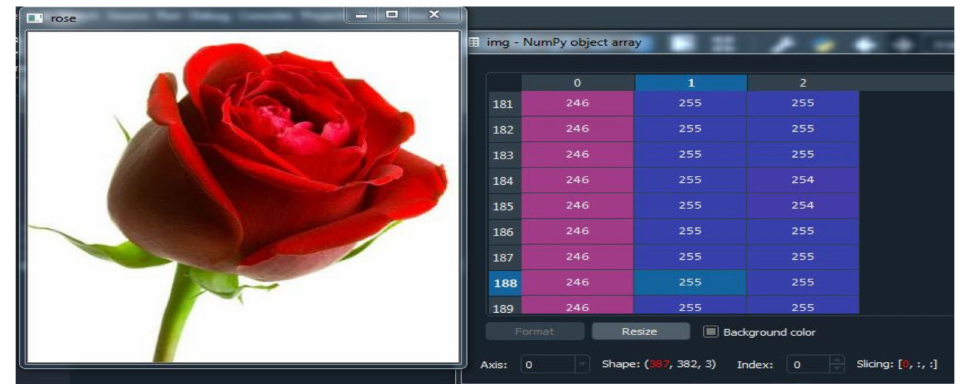
Figure 1. How computers visualize an image.